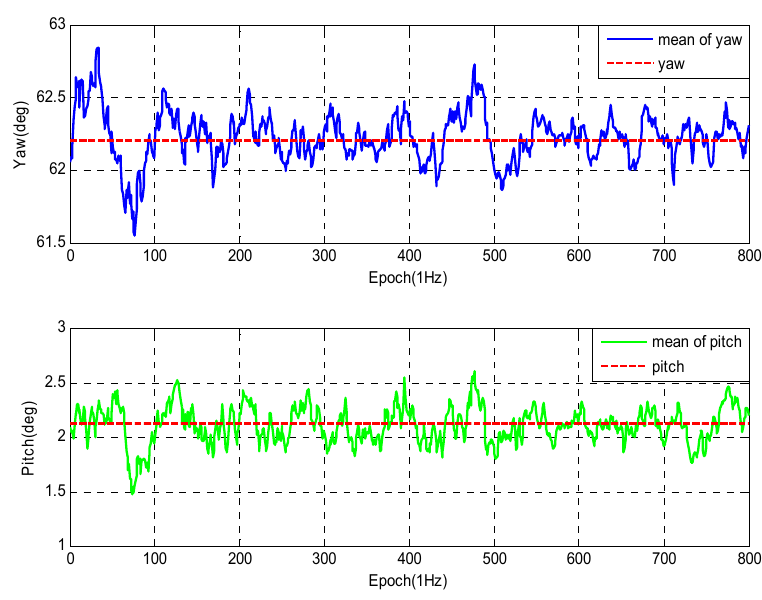
Figure 13. Experimental data of 2nd group.